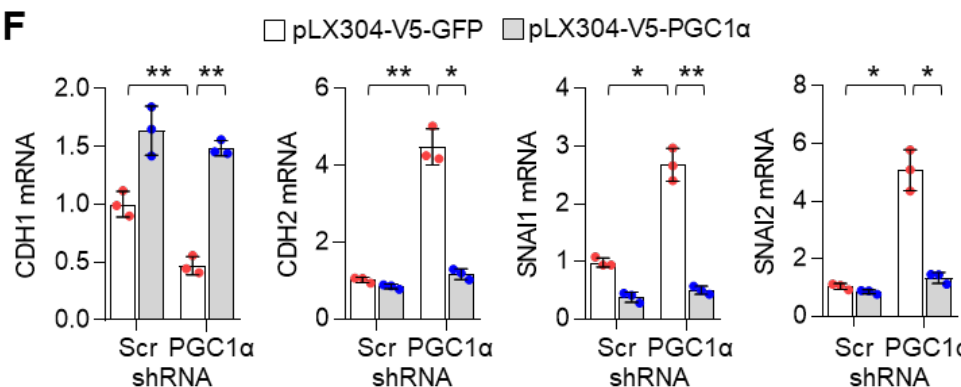
Figure 1. PGC1 α loss promotes the epithelial–mesenchymal transition (EMT) in lung cancer cells. ( A , B ) Plot and heat map for the top gene set and core enrichment genes of the gene set enrichment analysis (GSEA) in A549 cells. ( C ) Expression of the EMT genes quantified by qPCR. ( D ) Western blots of the three EMT proteins and PGC1 α in the control and PGC1 α -silenced cells. ( E ) Western blots of indicated proteins in cells expressing GFP (pLX304-V5-GFP) or PGC1 α (pLX304-V5-PGC1 α ) in the control and PGC1α knocked-down A549 cells. ( F ) qPCR of EMT genes. Values represent mean ± SD ( n = 3). * p < 0.05 and ** p < 0.01 by Student’s t -test. The whole western blot images are showed in Figure S7.